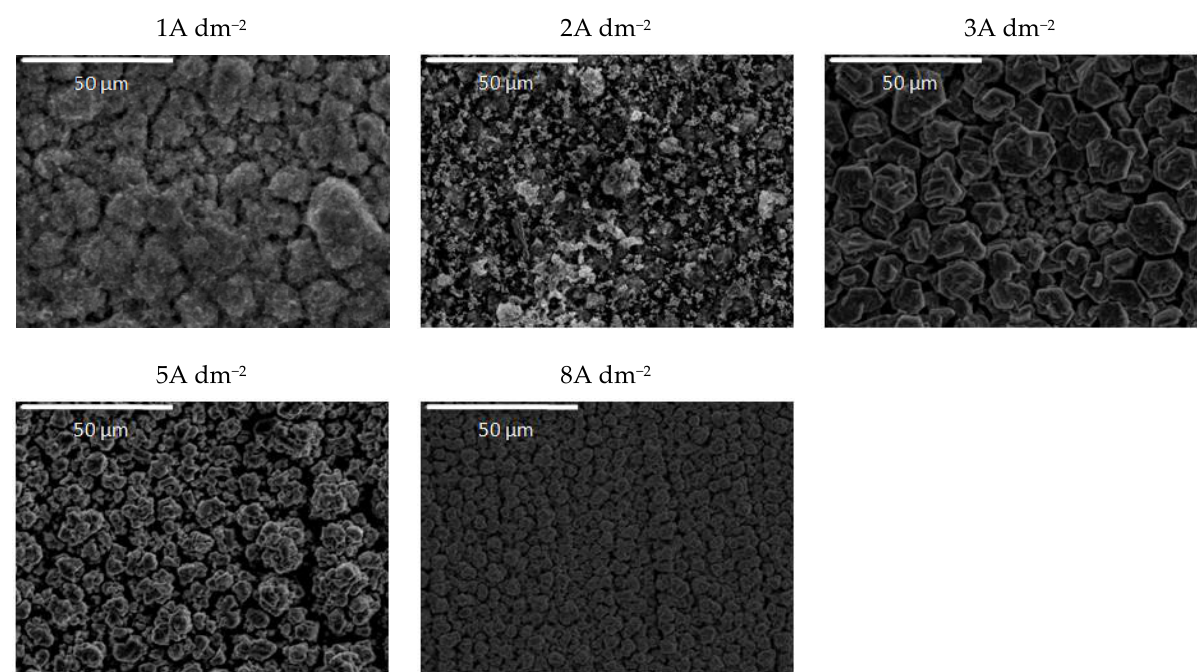
Figure 12. Morphology of the Zn-Co-CeO 2 composite coatings ultrasounddeposited at different current densities from plating solution with 0.2 wt.% ceria sol.